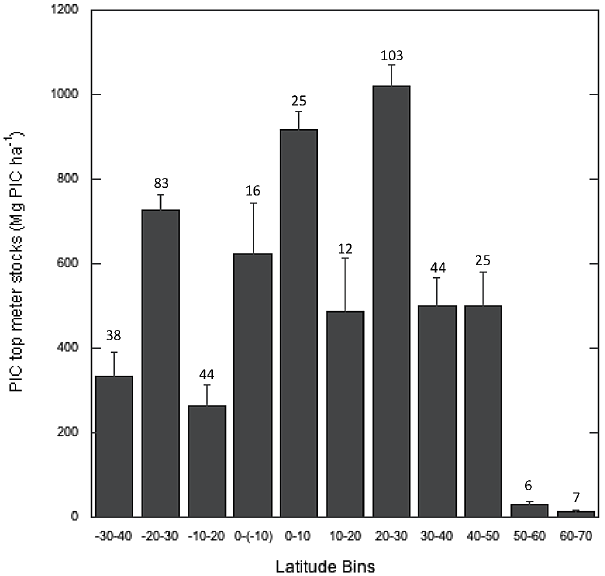
Figure 5. Frequency distribution of the POC:PIC ratio in the sea- grass sediments examined (392 sites; n =